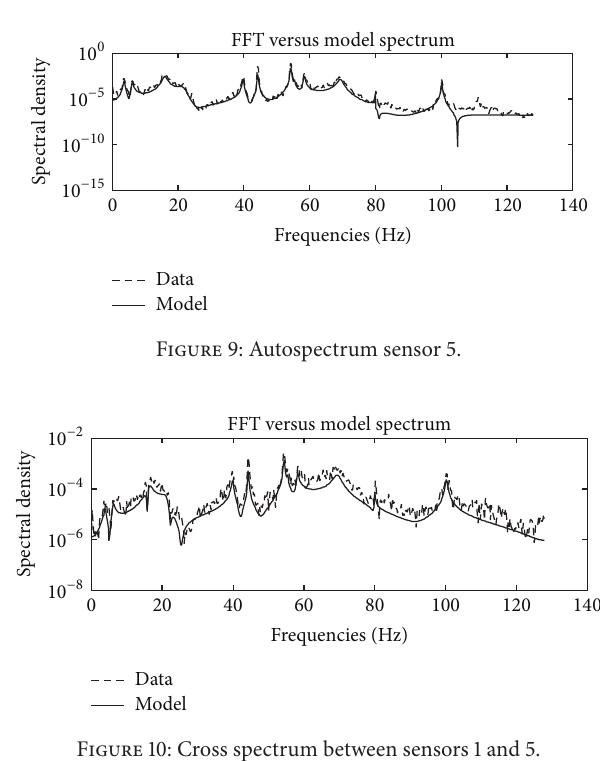
Figure 10: Cross spectrum between sensors 1 and 5.